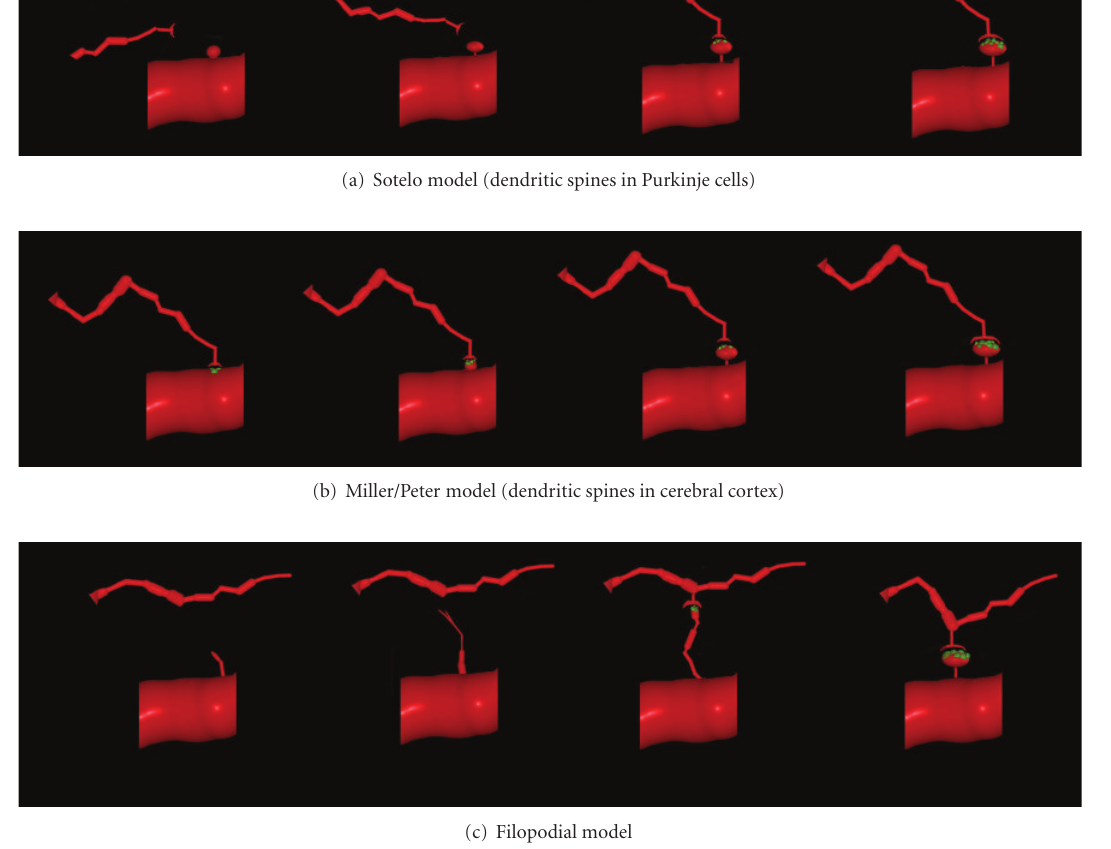
Figure 3: Models of spinogenesis based on the Figure 3 from Yuste and Bonhoe ff er [14]. (a) Sotelo model : dendritic spines emerge from dendritic trees by an autonomous cellular program, independently of the axonal terminals. (b) Miller/Peters model : dendritic spines are induced by axonal terminals on dendrites by a successive outgrowth through a sessile spine to a pedunculated one. (c) Filopodial model : filopodia become dendritic spines interacting with axons. Synaptic contacts in